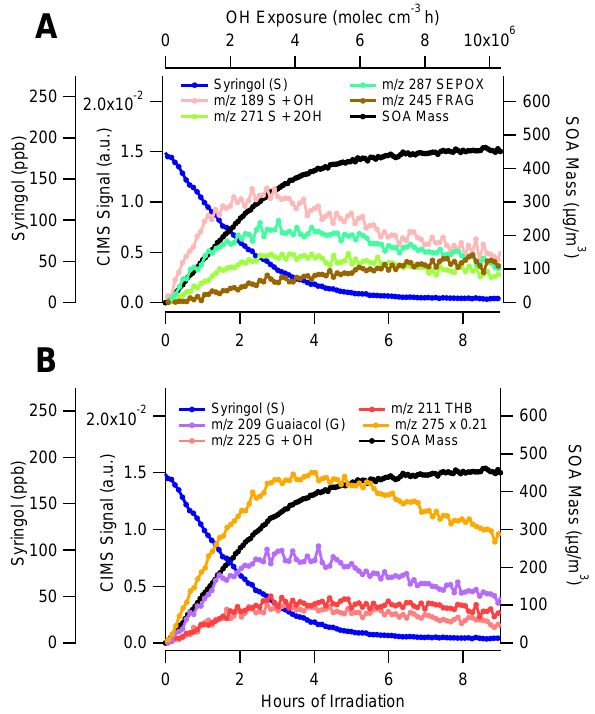
Fig. 7. Selected traces in syringol low-NO x gas-phase and particle- phase development. (A) OH addition pathways. (B) Traces indicat- ing methoxy loss